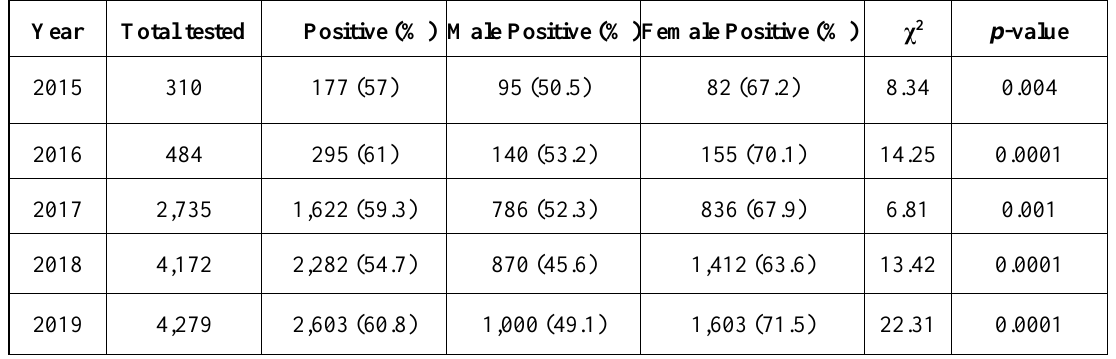
Table 2. Seroprevalence rate of H. pylori infection from January 2015 to December 2019.